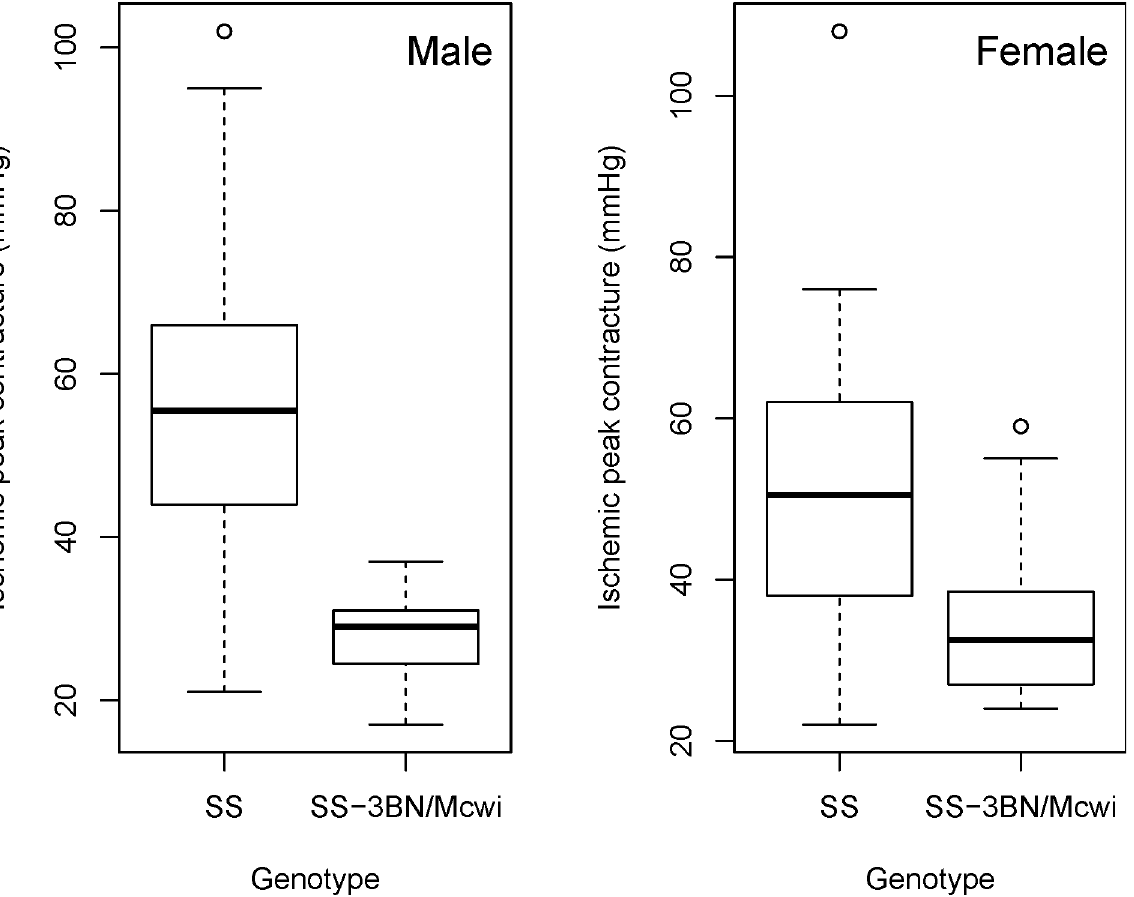
Fig 5. Example output of the PhenStat boxplotGenotypeSex function. Shown is the output from the boxplotGenotypeSex function obtained for the ischemic peak contracture pressure from a study on rats comparing SS strain to SS-3BN/Mcwi strain. Graphic highlights a visual difference in the variable of interest that could potentially be attributed to the genotype